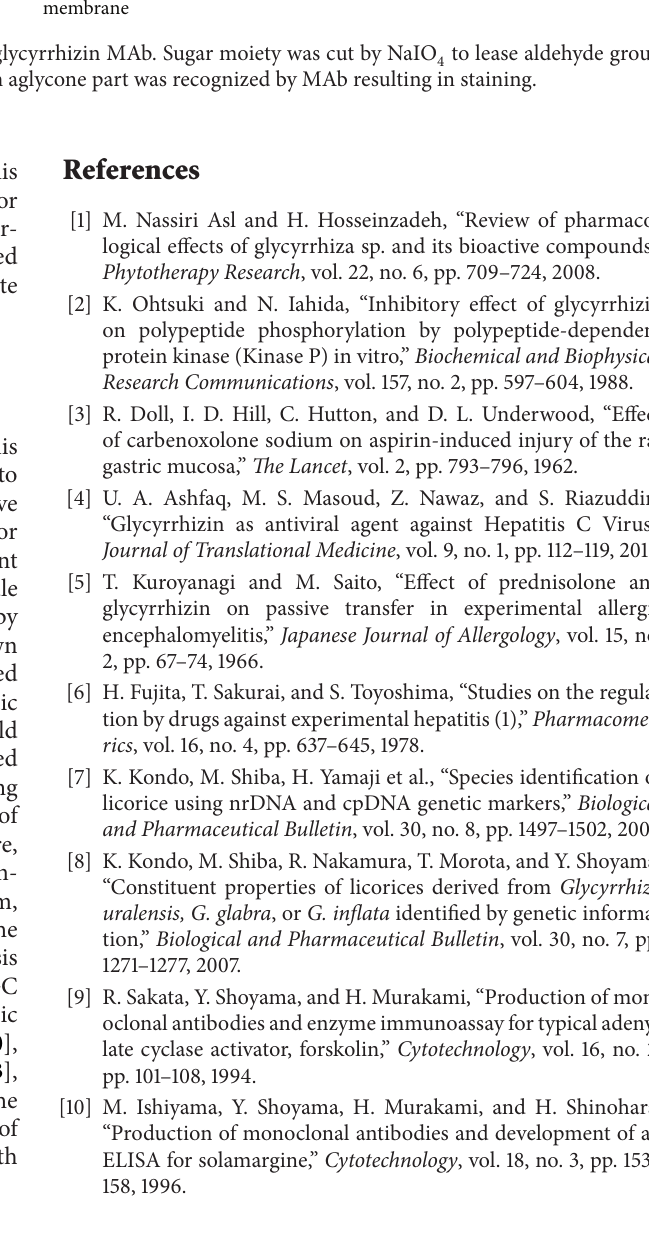
particles coated with anti-GC MAb can be used [39].